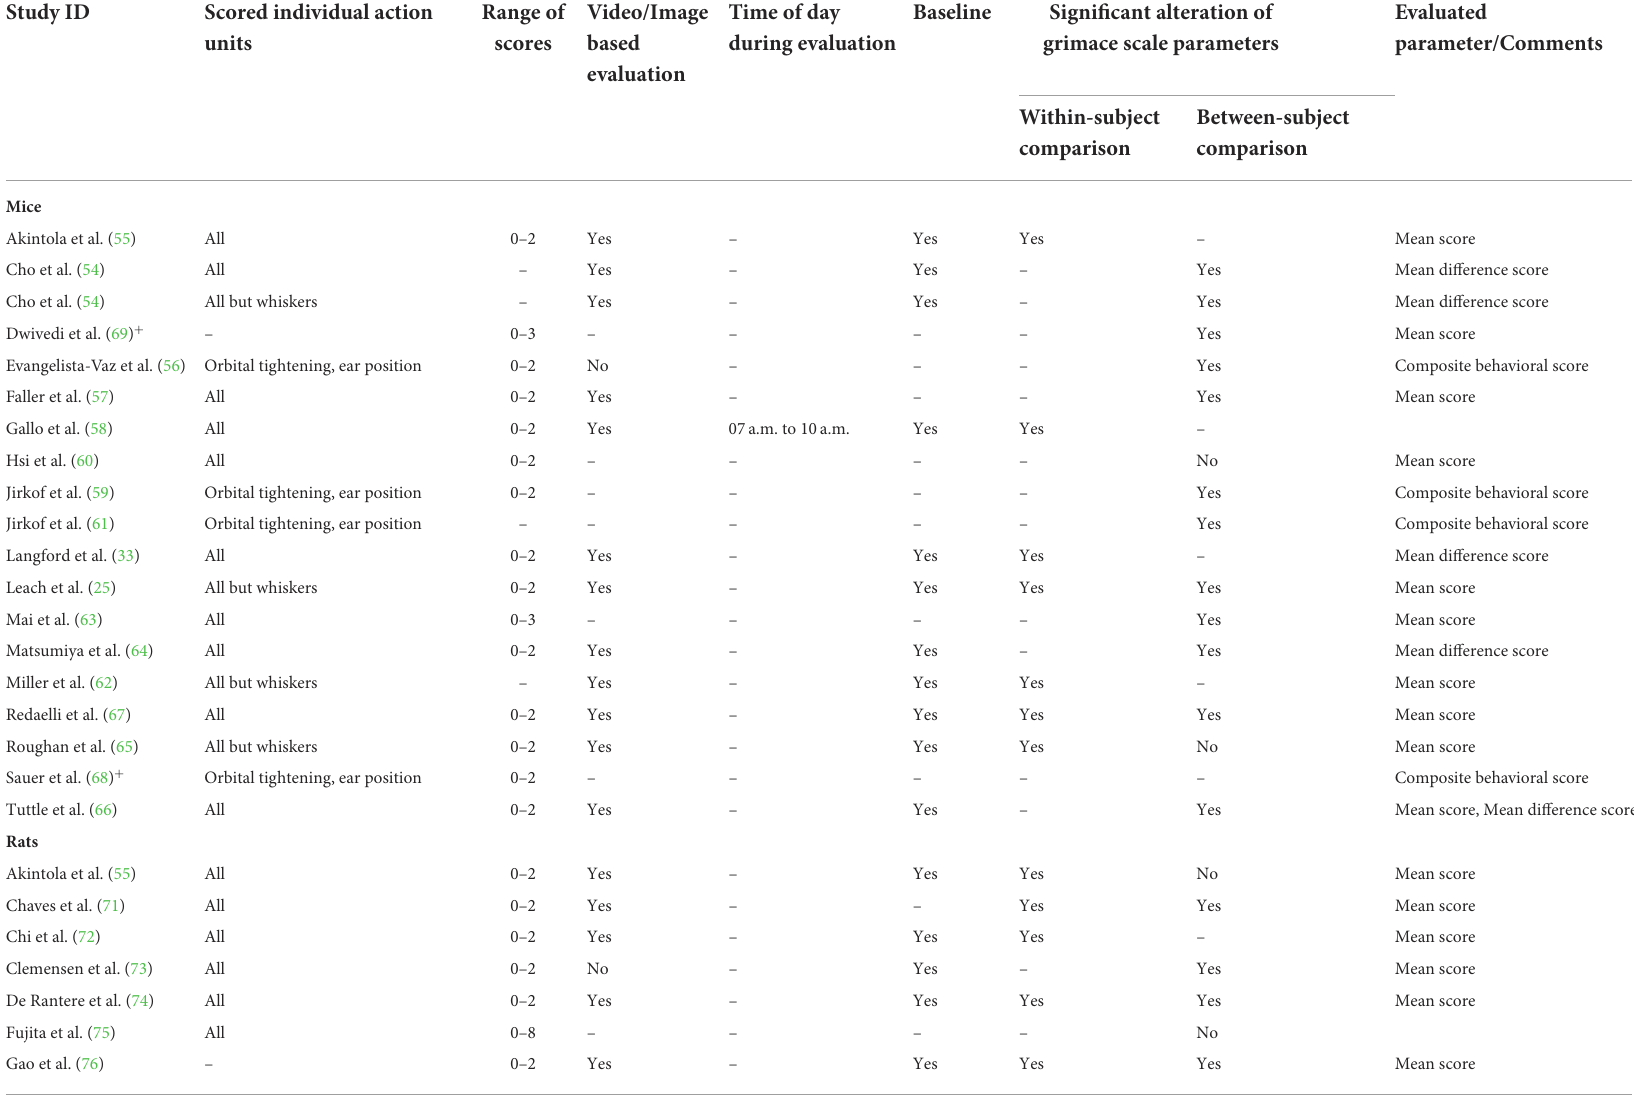
TABLE 4 Outcome characteristics for Mouse Grimace Scale (k = 18 studies) and Rat Grimace Scale (k = 29 studies). Study